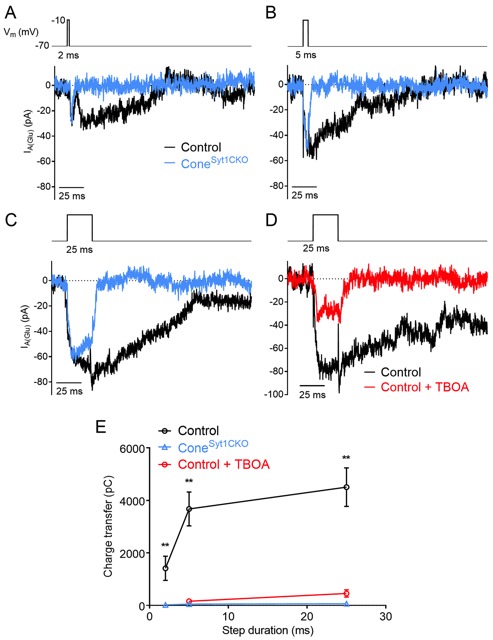
Glutamate release is eliminated in cones lacking Syt1.Example IA(Glu) recordings from control and Syt1-deficient cones in response to 2 (A), 5 (B), and 25 (C) ms depolarizing steps (−70 to −10 mV). (D) Example IA(Glu) recordings from a control cone evoked by 25 ms steps in control conditions and following bath application of the glutamate transport inhibitor, TBOA (100 μM). (E) IA(Glu) charge transfer as a function of step duration in control cones, ConeSyt1CKO cones, and control cones in the presence of 100 μM TBOA. Charge transfer was measured from the end of the test step. 2 ms: control: 1415 ± 463 pC, n = 7 cones; ConeSyt1CKO: 20.7 ± 7.6 pC, n = 9 cones; control vs. ConeSyt1CKO, p=0.0039. 5 ms: control: 3675 ± 646 pC, n = 19 cones; ConeSyt1CKO: 49.8 ± 11.3 pC, n = 8 cones; control +TBOA: 160.3 ± 51.3 pC, n = 7 cones; ConeSyt1CKO vs. control: p=0.0014, TBOA vs. control: p=0.0033. 25 ms: control: 4507 ± 734 pC, n = 17 cones; ConeSyt1CKO: 64.9 ± 29.9 pC, n = 10 cones; control +TBOA: 455 ± 139 pC, n = 9 cones; ConeSyt1CKO vs. control: p=0.0003, TBOA vs. control: p=0.0012 (t-tests corrected for multiple comparisons).